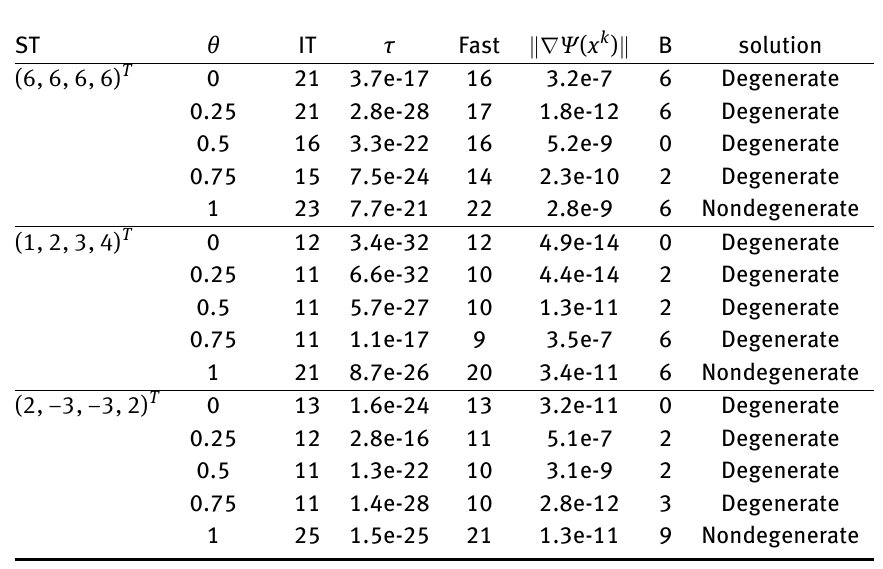
Table 2: Numerical behavior for Example